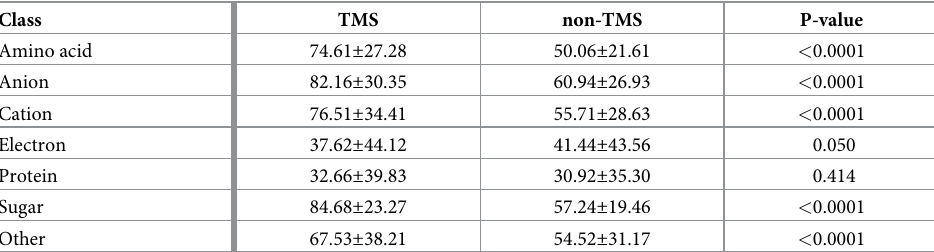
All the data are reported as the sample mean ± the standard deviation (SD). The location of the TMS regions was predicted using TOPCONS2 [58] for the α -helical TMS and PRED-TMBB2 [59] for β -barrel TMS regions. There are statistically (P-value < 0.0001) significant informative positions in TMS regions compared to non-TMS regions, in the sequences that belong to amino acid , anion , cation , sugar , and other classes.